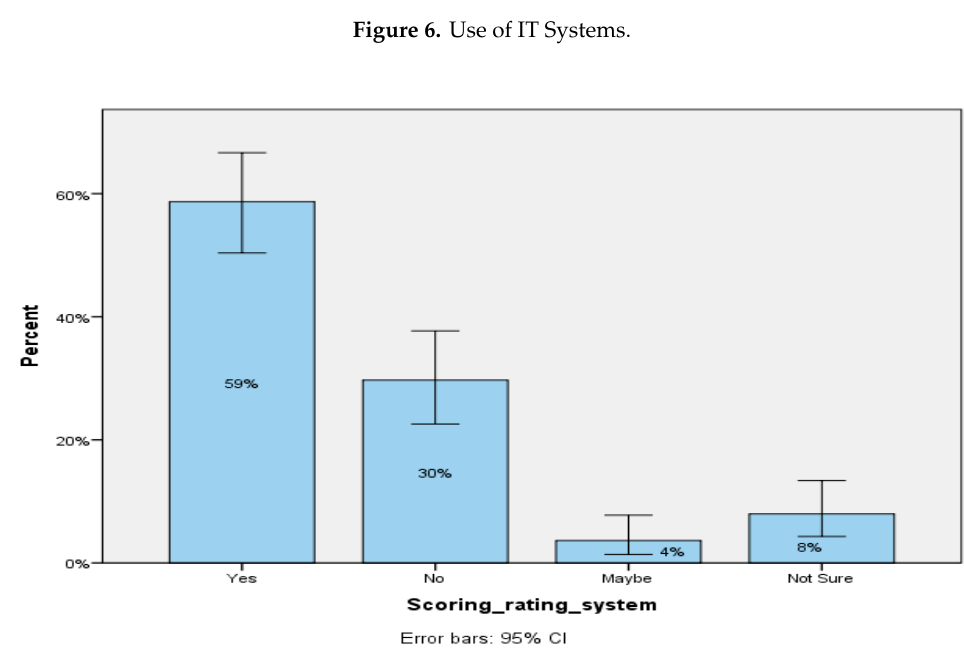
Figure 7. Use of Figure 7. Use of metrics.